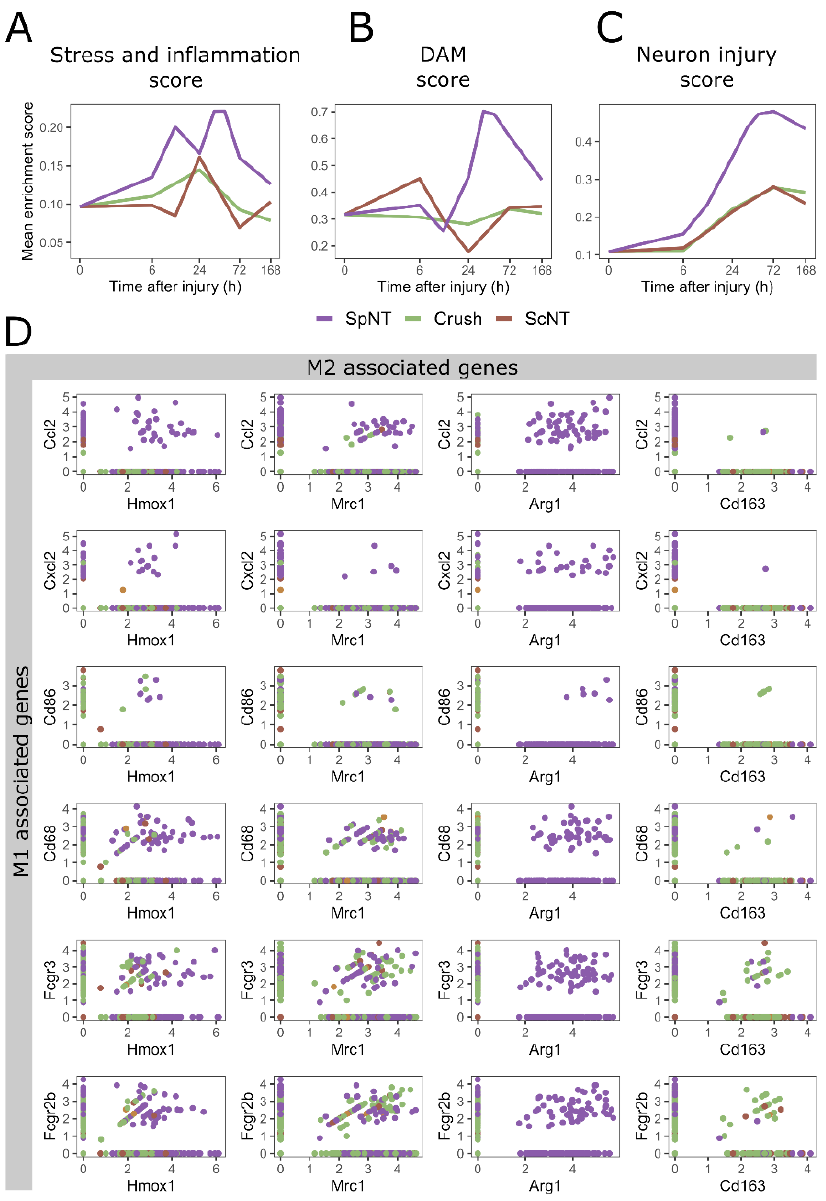
Figure 2. The time course of DRG macrophage responses to peripheral nerve injuries are dependent on the site and type of injury. ( A ) Mean enrichment score of stress and inflammation associated genes following different PNI models. ( B ) Mean enrichment score of DAM associated genes. All nuclei annotated as macrophages were included in the mean score in ( A ) and ( B ). ( C ) Mean enrichment score of neuronal injury associated genes. All nuclei annotated as neurons were included in the mean score calculation. ( D ) Co-expression of the classical M1 (y-axes) and M2 (x-axes) marker genes in individual macrophage nuclei after PNI models. Axes represent the normalized expression values. The scales of the x-axes in ( A – C ) are transformed to log2. Abbreviations: spinal nerve transection (SpNT); sciatic nerve crush (Crush); sciatic nerve transection (ScNT); disease-associated macrophage (DAM) .